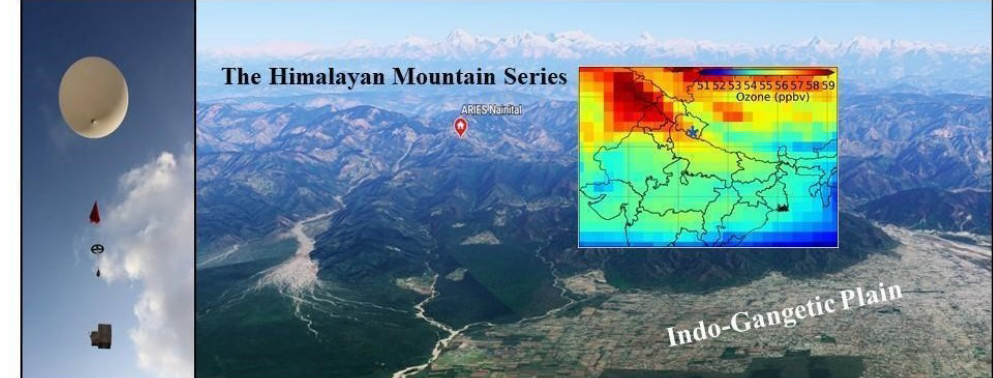
Figure 1. Location (red colour circle) of the balloon launching site (© Google Earth, 2021) situated in the Aryabhatta Research Institute of Observational Sciences (ARIES) (29.4 ◦ N, 79.5 ◦ E; 1793m elevation), Nainital, in the central Himalayas. The spatial distribution of ozone (AIRS) at 500hPa is also shown over northern India, and the location of the site is marked with a blue star. A photo of balloon, together with parachute, unwinder, ozonesonde, and GPS radiosonde, above the observation site is also shown at the